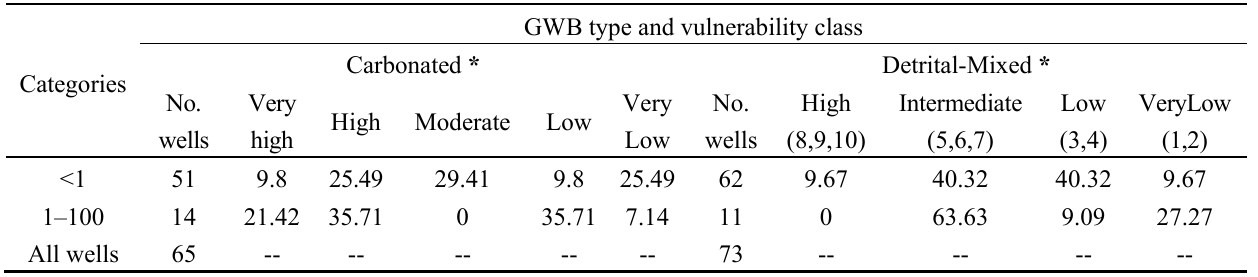
Table 4. Distribution of wells for groundwater body (GWB) type and category.